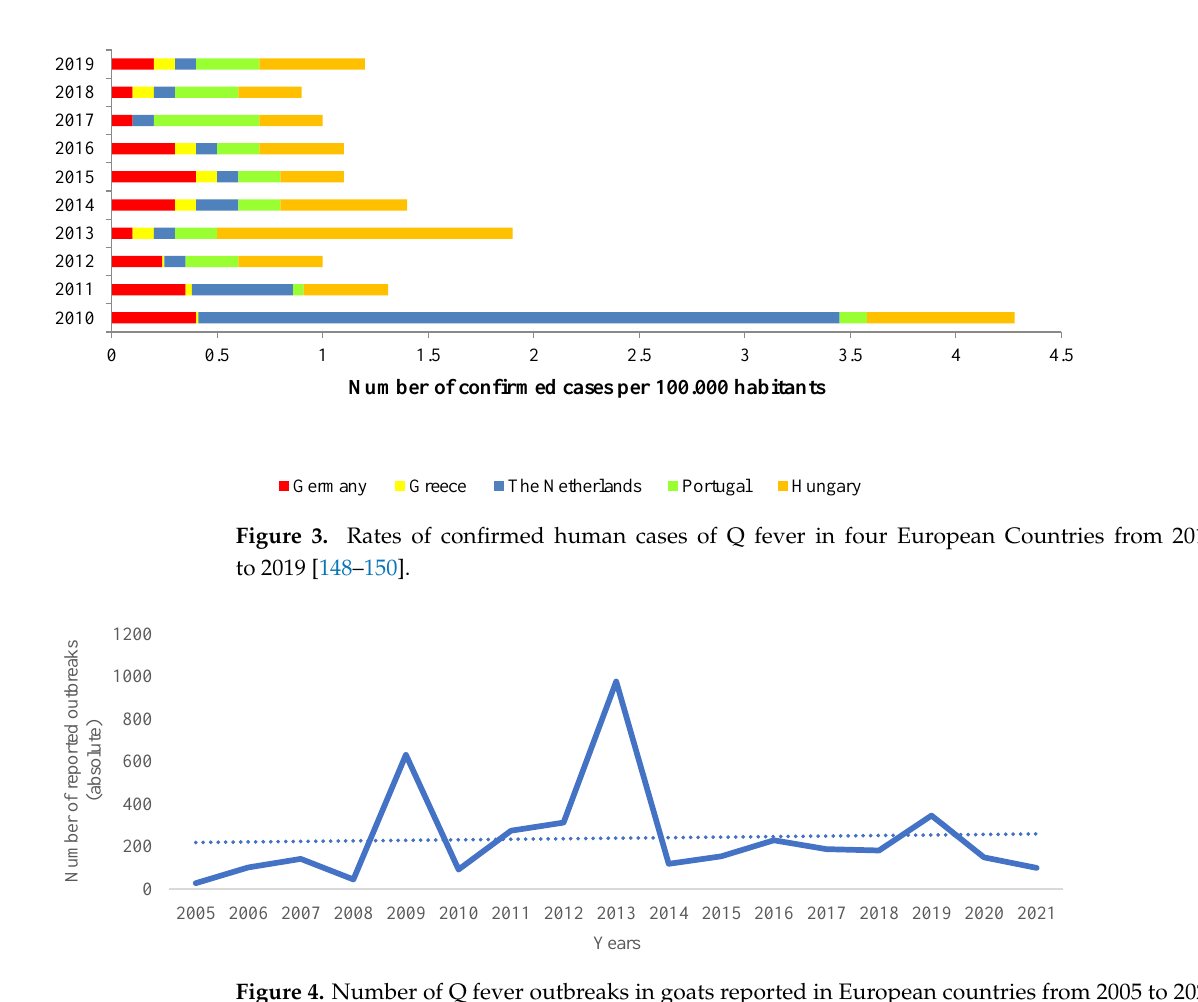
Figure 4. Number of Q fever outbreaks in goats reported in European countries from 2005 to 2021 and linear trend line [8].